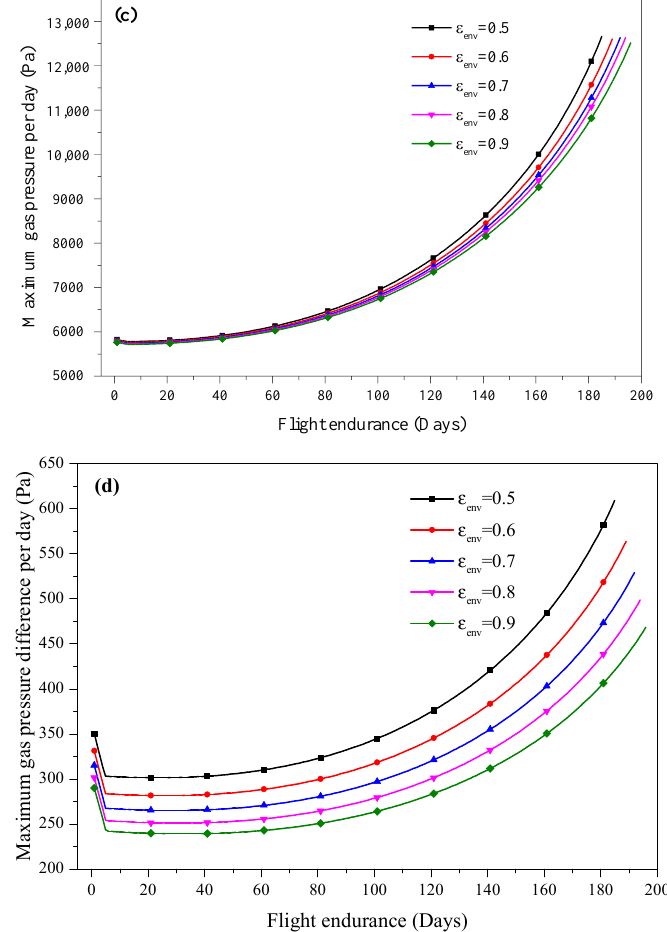
Figure 19. Effects of envelope emissivity on the ( a ) maximum skin temperature per day, ( b ) maximum gas temperature per day, ( c ) maximum gas pressure per day, and ( d ) maximum gas pressure difference per day.